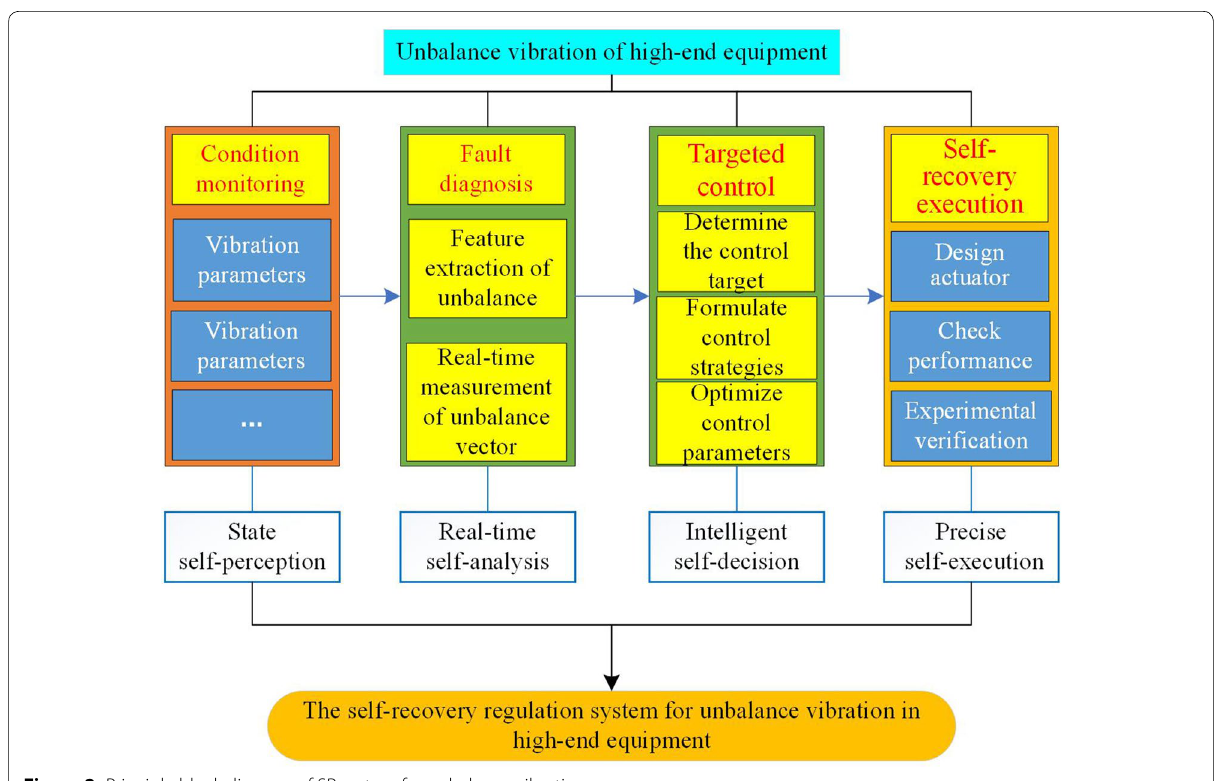
Figure 2 Principle block diagram of SR system for unbalance vibration